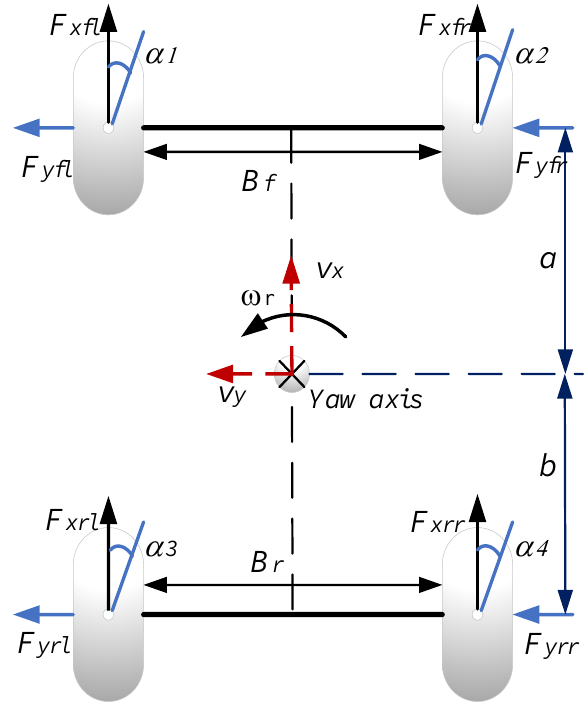
Figure 2. Vehicle straight-line driving dynamics model.